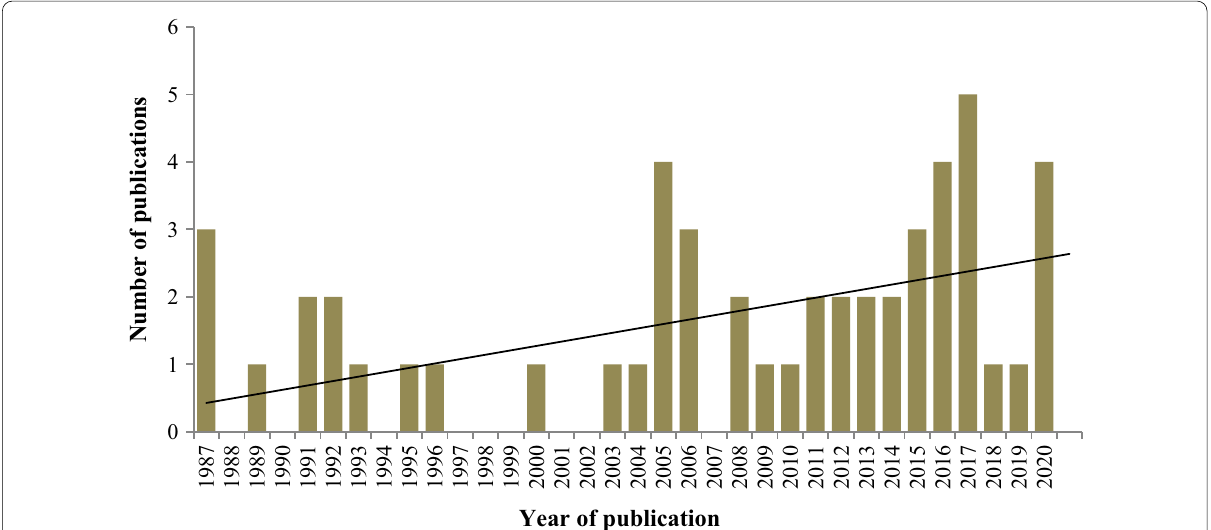
Fig. 2 Trend of malaria publications in Central African Republic of 1987 at